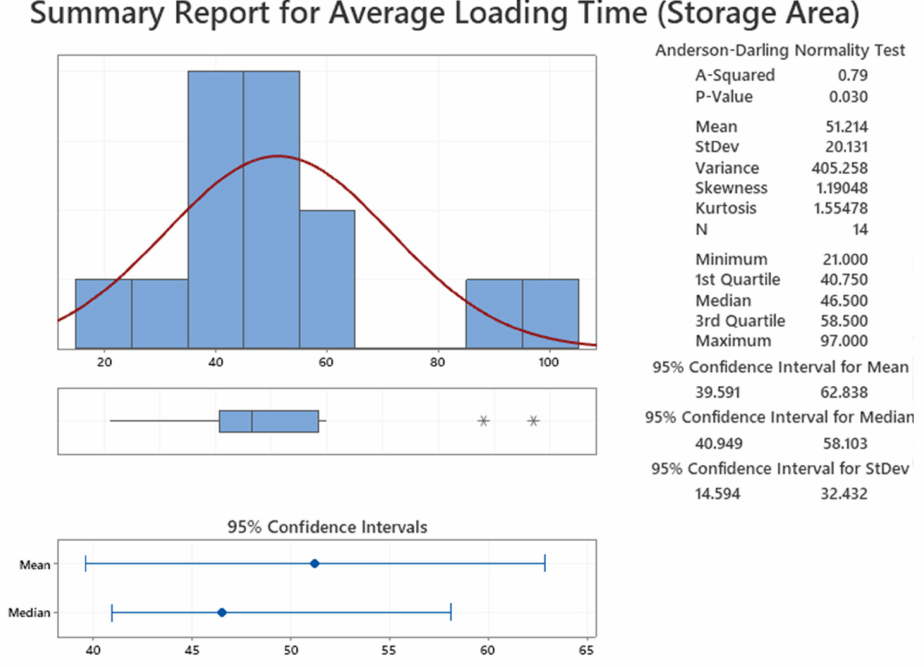
Figure 5. Average loading time in the storage